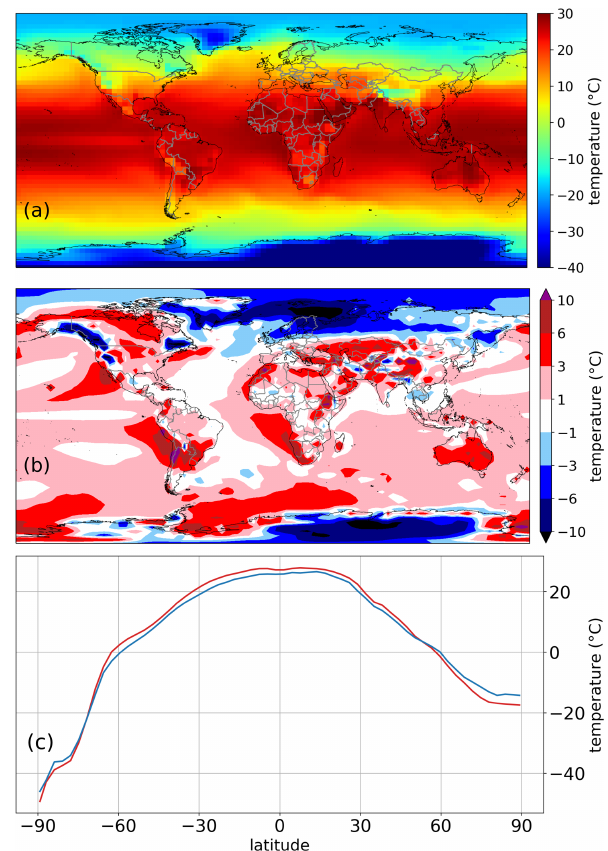
Figure 6. (a) Global mean surface temperature of the TR experi- ment over the 1994–2003 period. (b) Surface temperature anoma- lies between CM2Mc-LPJmL (TR) and ERA5 data over the 1994– 2003 period. (c) Latitudinal temperature mean of TR (red line) and ERA5 data (blue line) for the 1994–2003